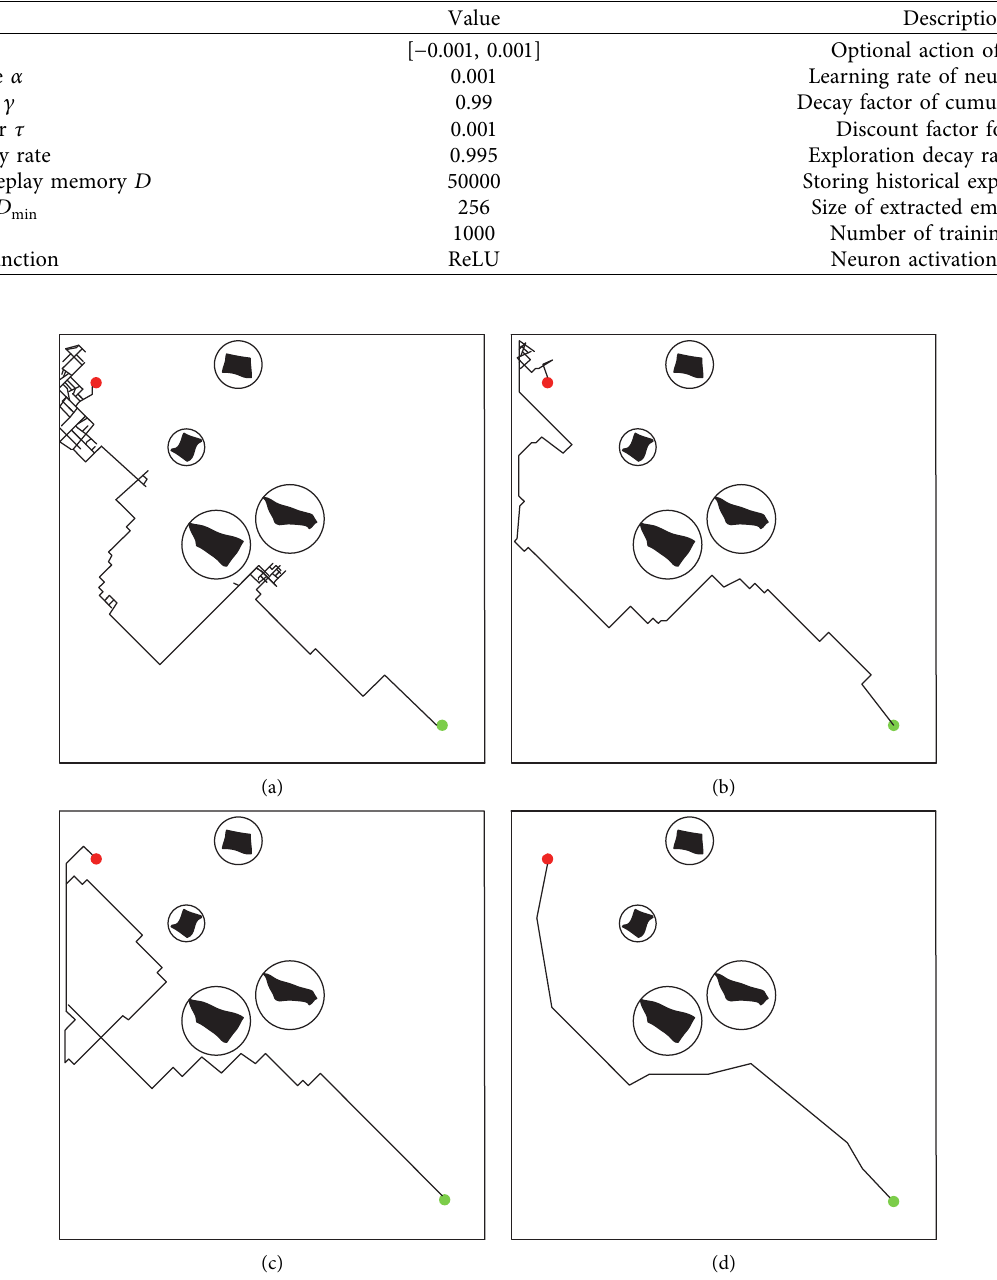
Table 2: Parameter settings.